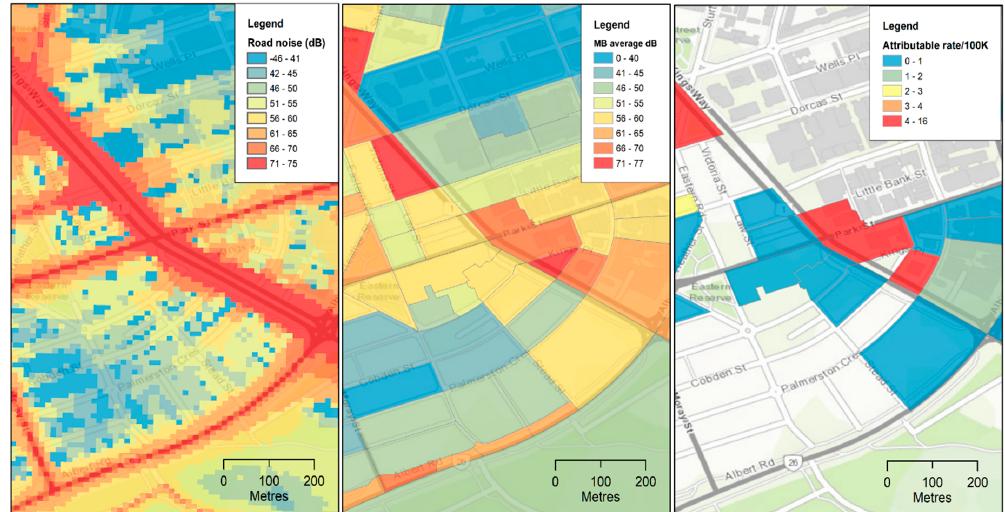
Figure 2. Maps showing road traffic noise exposures and expected rates of premature attributable cardiovascular deaths (per 100,000 people) in selected ABS mesh blocks of Melbourne generated using the interactive mapping application.